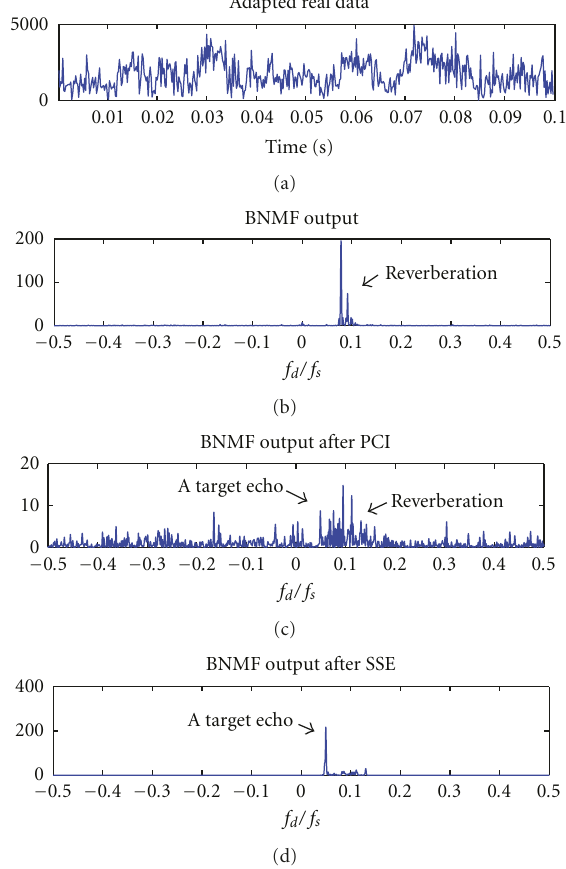
Figure 3: Adapted active sonar data, BNMF outputs without processing, and after PCI and SSE with SSR = − 22 dB, f d / f s = 0 .